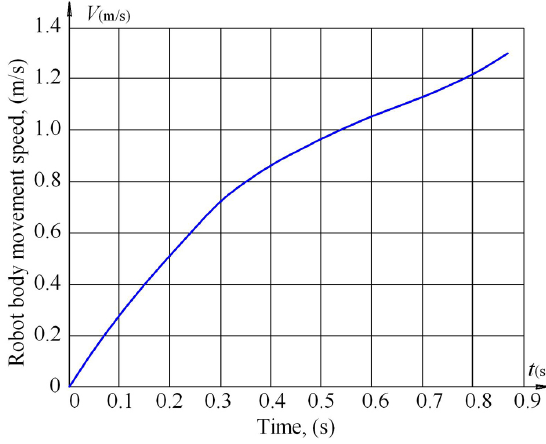
Figure 7. Graph of the change in the speed of the robot Figure 8 shows the changes in the angular velocities of the supporting leg of the robot, i.e., when the foot is in contact with the moving surface and changing